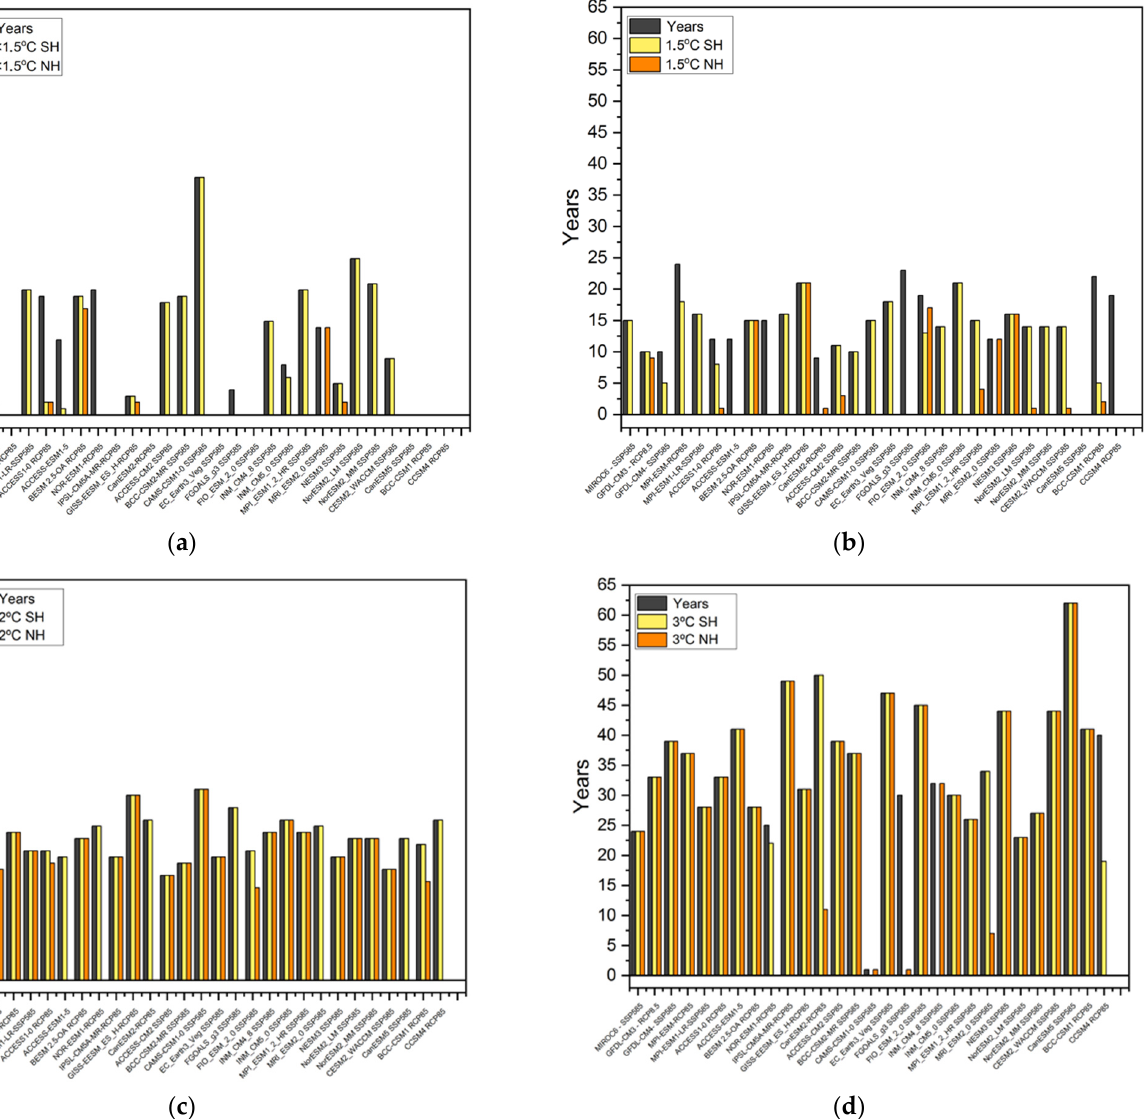
Figure 7. Number of years that each model takes to reach the different global warming thresholds (black bars). The number of summer ice-free occurrences in the Arctic (Antarctica) for each CMIP model are represented by the orange (yellow) bars. ( a ) Up to +1.5 °C threshold; ( b ) the period between the +1.5 °C and +2 °C global warming thresholds; ( c ) the period between the +2 °C and +3 °C global warming thresholds; and ( d ) the period between the +3 °C global warming thresholds and onwards until 2100 (end of simulation).